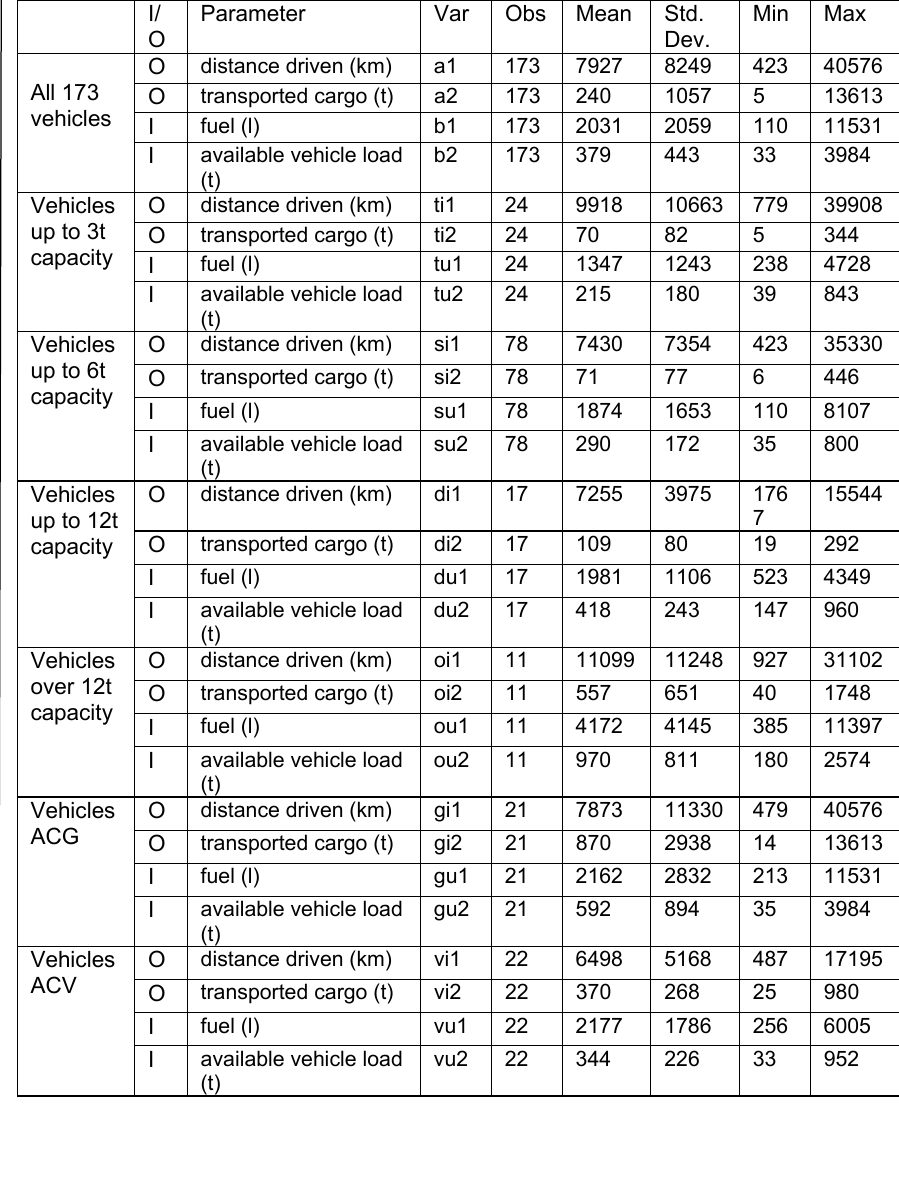
Table 6 – Descriptive statistics of inputs and outputs for vehicles Таблица 6 – Описательная статистика вводов и выводов транспортных